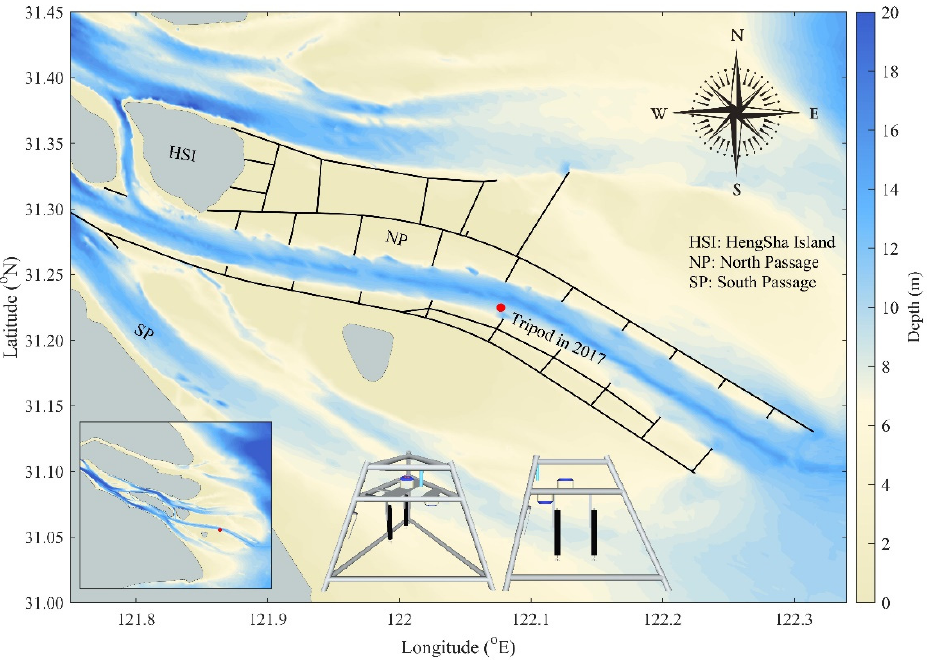
Figure 1. Bathymetry of the North Passage and adjacent regions. Black lines in the river mouth represent dikes and groins around the North Passage. Red dots indicate the measuring site in 2017. The insets show the bathymetry of the whole Changjiang estuary, and the tripod system used for near-bed observations.